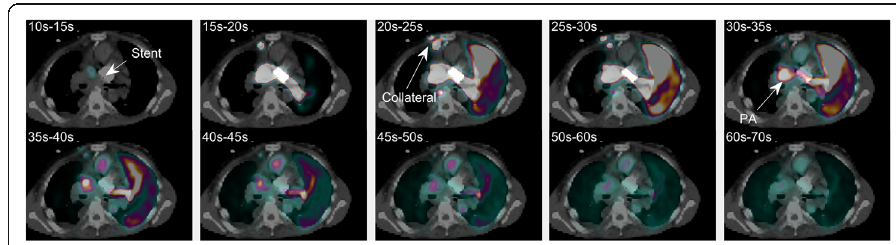
Fig. 4 Transaxially fused images of dynamic 15 O-water PET and CT. A pulmonary artery stent is shown together with collaterals and the pulmonary arteries